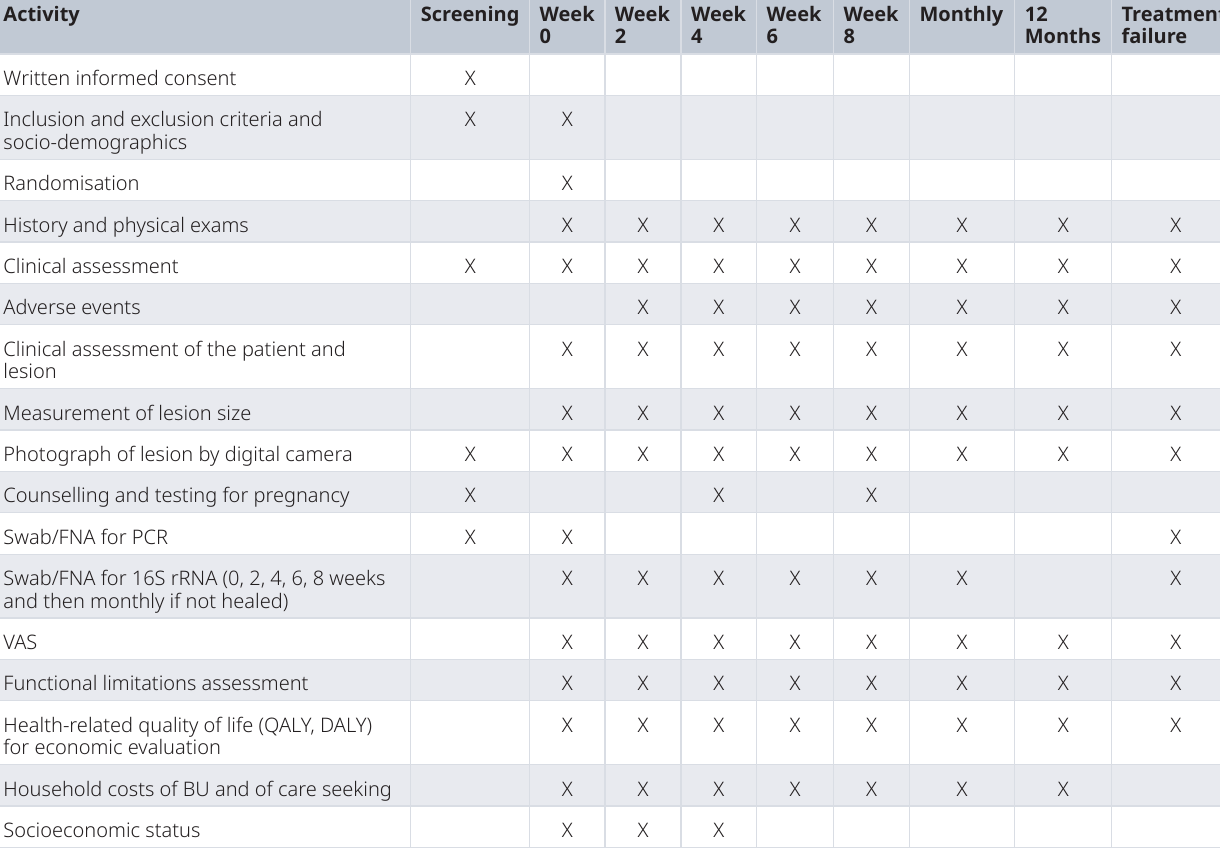
Table 1. Schedule of procedures for study participants. BU: Buruli